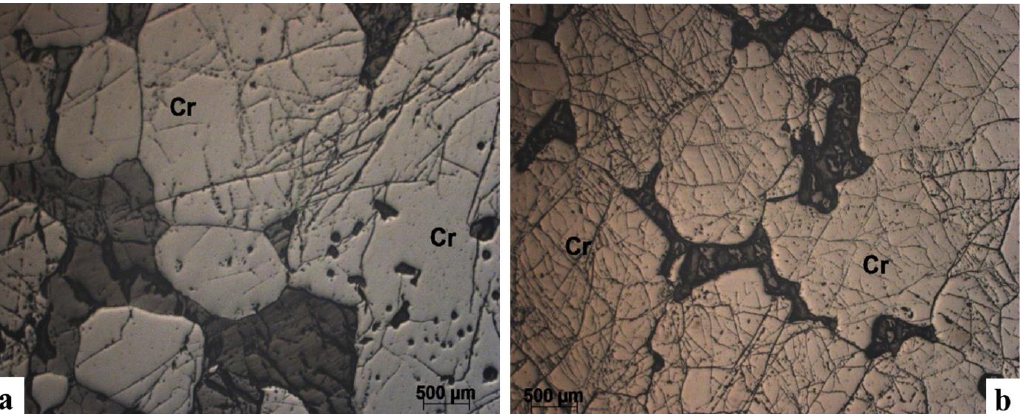
Figure 10. Microphotographs of the provided polished thin section from the selected samples under the reflected light microscope; ( a ) chromite particles surrounded by the altered ultramafic-associated minerals, e.g., olivine and serpentine; ( b ) chromite nodes with high cracks and adjacent ultramafic altered minerals. Cr, chromite. In Afghanistan, the ophiolitic complexes have limited distribution. They are distrib- uted in the eastern and central regions of the country and are accompanied by active fault and suture zones. Over the eastern extent of Afghanistan, two distinct ophiolitic com- plexes, the Logar and Khost ophiolites, were obducted onto the Kabul block and the In- dian margin [6]. Based on [6], the eastern ophiolites of Afghanistan, including the Logar Ophiolite Complex, mapped in this study are related to the final closure of the Tethys Ocean in the Cretaceous and Lower Tertiary, taking into account that the Indian plate moved rapidly northwards to the Eurasian plate and, finally, both obductions occurred later than Maastrichtian but before the Middle Eocene, presumably in the Paleocene. However, the emplacement mechanism and ages of the Logar ophiolite complex are con- tradictory and require a detailed investigation. Previous remotely sensed ophiolitic studies in the Logar Ophiolitic Complex only detected the spatial distribution of mafic–ultramafic rocks; however, the ophiolite is com- posed of mafic–ultramafic layers with different rock types. Therefore, the geological data from field investigation were integrated with the results of remote sensing data to fill this gap and clarify the rock types. The samples taken during the field observation were used to validate the findings of the remote sensing data and describe the petrographic and min- eralogic properties of the detected complex in the study area. The samples were collected randomly and superimposed on the detected complex. They were completely matched, thus verifying the accuracy of the remote sensing approach. The spatial distribution of the samples collected across the study area is shown in Figure 8. Based on the mineralogical compositions interpreted during the microscopic analysis and remote sensing interpreta- tion, the mapped mafic–ultramafic complexes are composed of dunite, harzburgite, py- roxenite, websterite, and serpentinite, with the associated ore minerals, particularly chro- mite and mafic layers (Figures 9 and 10). The macroscopic photographs of related ultra- mafics are depicted in Figure 11.